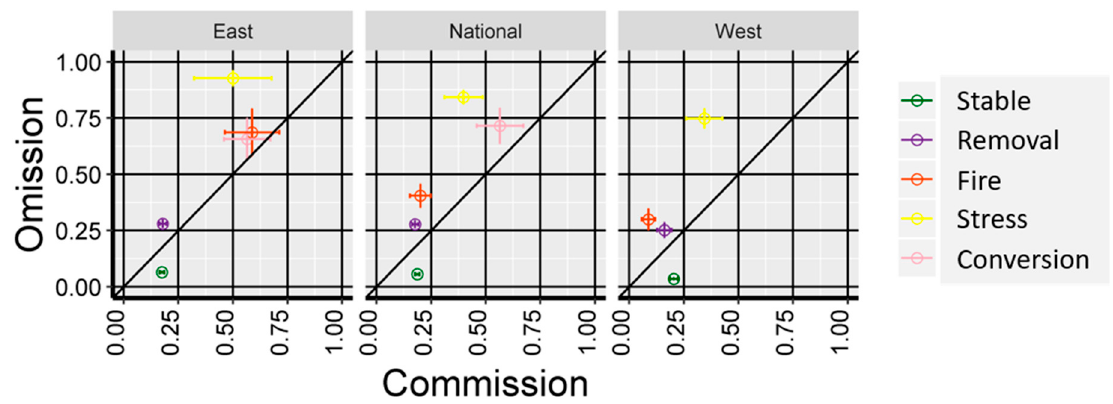
Figure 3. Accuracy metrics for East and West models are weighted by sampling strata to derive national accuracy metrics. The x -axis quantifies commission (false positive) errors. The y -axis quantifies omission (false negative) errors. Error bars along the y -axis denote sampling error (S.E.) for omission accuracy metrics and error bars along the x -axis gauge sampling error (S.E.) for commission accuracy metrics. User’s accuracy is equal to 1 – omission. Producer’s accuracy is equal to 1 – commission.